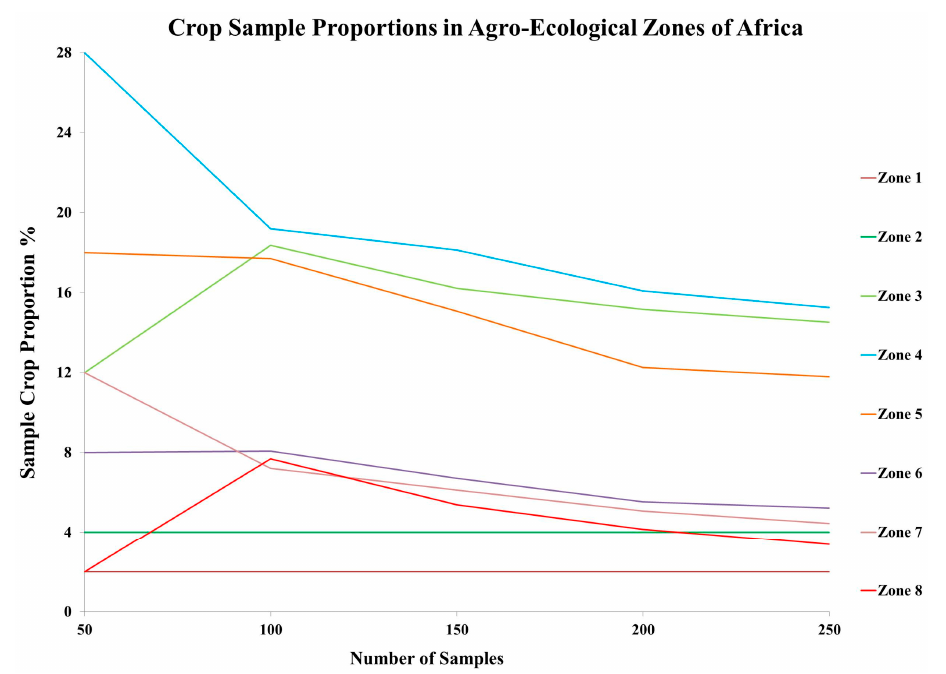
Figure 8. The graph showing the sample simulation in AEZ’s of Africa.